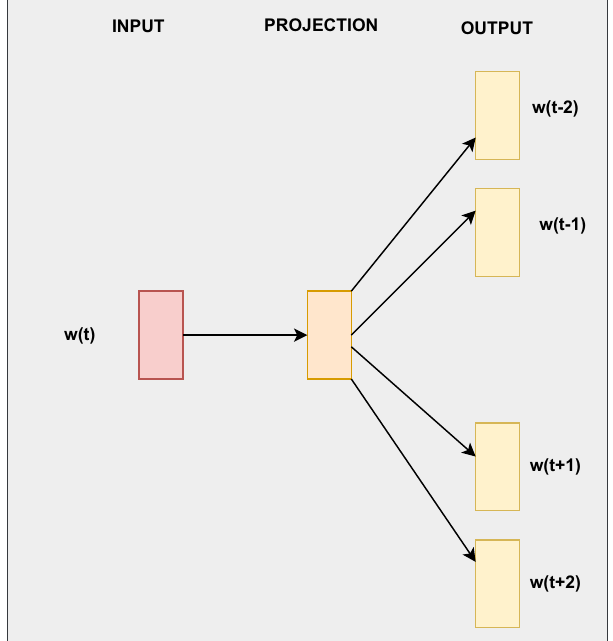
Figure 5: SGram structure ( Source: https://arxiv.org/pdf/1301.3781.pdf Mikolov et al., 2013 )